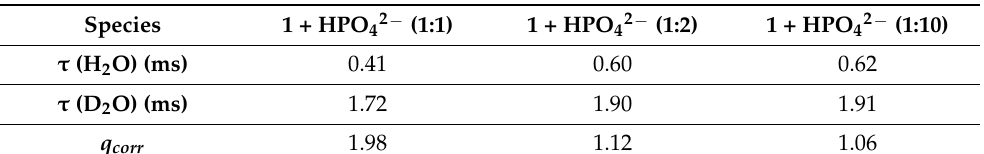
Table 2. Summary of the changes in the lifetimes of complex 1 in the presence of different equivalent HPO 42 − in aqueous media (H 2 O as well as D 2 O).